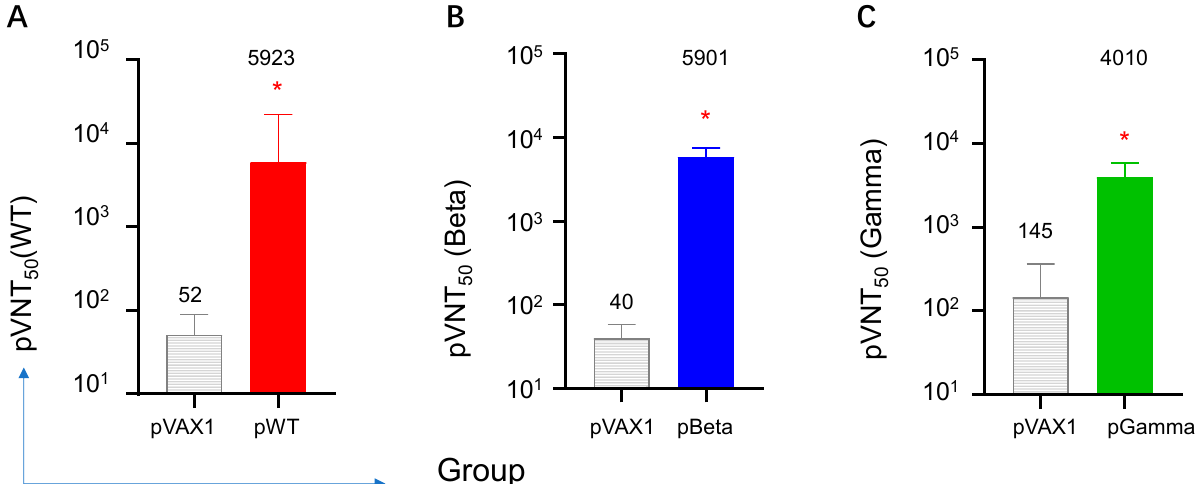
Figure 5. In vivo killing assay on day 21 post-immunization. An equal amount of 5 nM eflour 450-labeled SARS-COV-2 WT spike RBD-originated peptide-pool-pulsed splenocytes and 0.5 nM eflour 450-labeled un-pulsed splenocytes from naïve C57BL/6 mice were used as target cells and adoptively transferred to mice from each group. The specific killing percentage was calculated as described in the Section 2 . ( A ) Specific killing percentage on day 14, ( B ) specific killing percentage on day 21 by DNA vaccine pWT, pBeta, and pGamma ( n = 3). *** denotes a significant difference compared with pVAX1 ( p < 0.001).